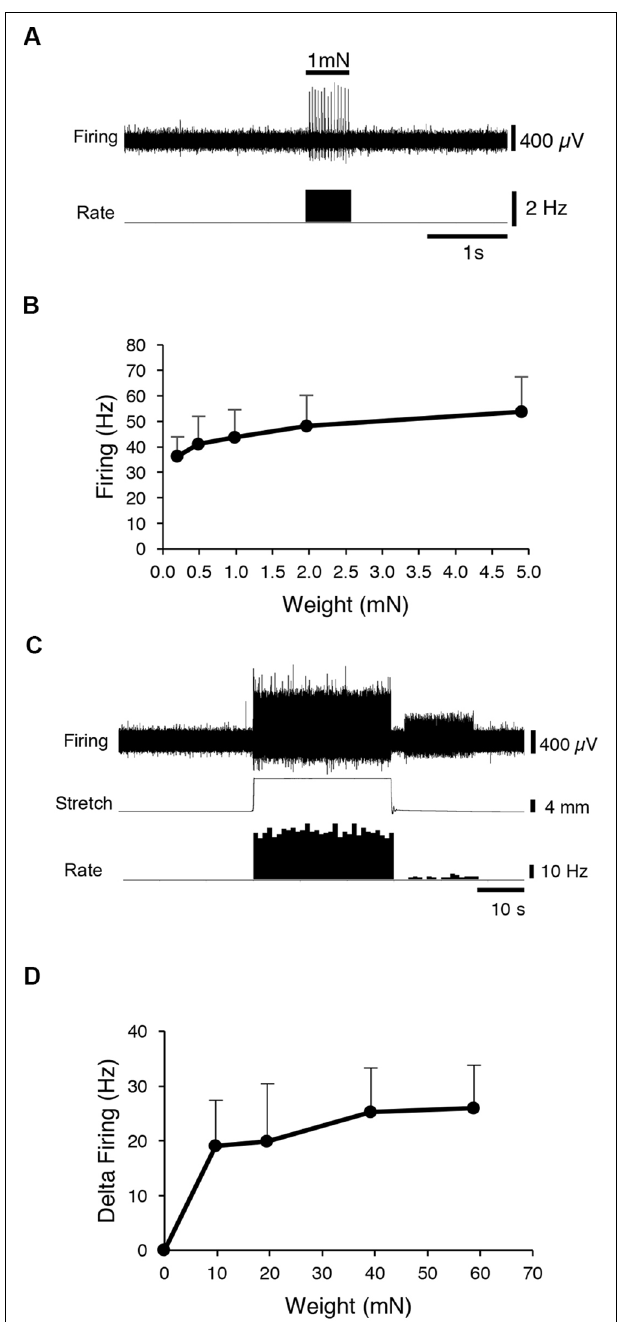
FIGURE 1 | Identification of CT3 afferents. CT3 afferents, recorded from segmental nerves to abdominal muscles were identified by their responses to graded von Frey hairs and responses to stretch. (A) Typical responses to 100 mg von Frey hair. (B) Mean results of a von Frey hair stimulus-response curve for 14 units. (C) Typical tonic response to a 2 g load. (D) Mean responses to a range of loads applied to the preparation (14 units, n = 13. These responses are similar to those reported previously for CT3 afferents (Peterson et al., 2019).